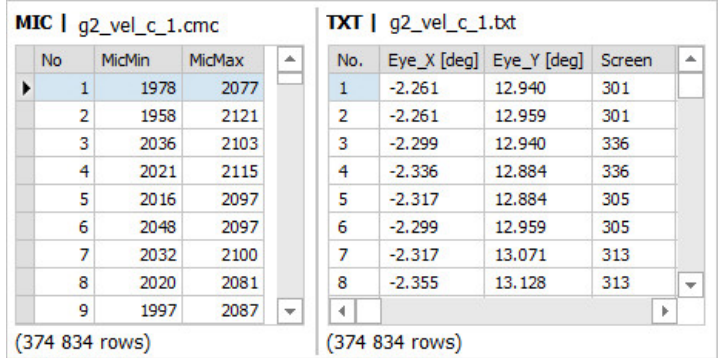
Figure 5. Combining the signals from the microphone and from the saccade sensor. Handling the data from two structures that are different in data type, one of which contains string values, is inconvenient. It is necessary to convert the eye movement information data, which are currently of text type, to the corresponding base (structural) types. This conversion is done in parallel with the process of merging the eye movement data and the pairs of MicMin and MicMax values, which correspond to the minimum and maximum value of the audio signal for the corresponding segment, but extracted from the text file. The eye movement data are initially loaded and buffered into an array of strings whose elements are record type variables that hold 5 different values each. These values correspond to each field that is exported to the text file that stores the eye movement information. To join the two sets of records, the relation Movments = {No, EyeX, EyeY, Screen, MicMin, MicMax} was created. The first 4 fields correspond to the columns of the same name from a text file, and the last 2 fields correspond to the minimum and maximum value of the microphone signal for the current sample. In this relation, the “No” attribute actually represents a primary key and uniquely identifies each row of the formed